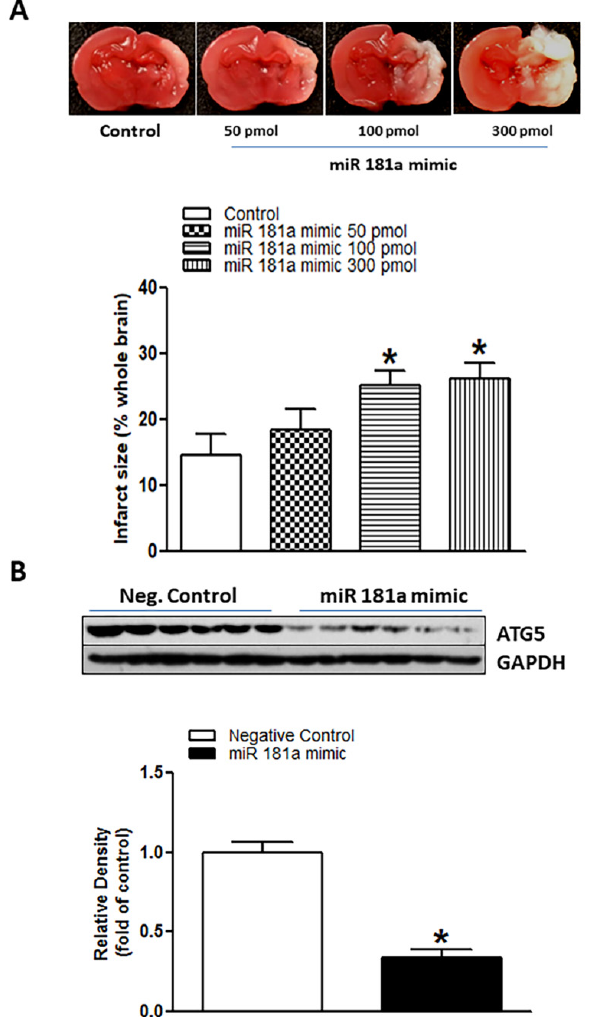
Figure 2. MiR-181a mimic reduced ATG5 protein level and exaggerated hypoxia/ischemia (H/I)- induced brain injury in neonatal pups. Different concentrations of miR-181a mimic and negative control were administered intracerebroventricularly (i.c.v.) on postnatal day 7 (P7) pups. Then, H/I procedure was conducted on postnatal day 9 (P9). After 48 h of H/I procedure, brain infarct size was determined by 2,3,5-triphenyltetrazolium chloride (TTC) solution staining ( A ). As shown in ( A ), miR-181a mimic administration significantly increased H/I-induced brain infarct size in a dose-dependent manner and reduced protein levels of ATG5 ( B ) in neonatal rat brains. Data are means ± SEM. * p < 0.05, control vs. miR-181a mimic, n = 7–12 animals/group. ATG5 protein level was evaluated by Western blotting in the P9 neonatal brain ( B ). Data are means ± SEM. * p < 0.05, control vs. miR-181a mimic (100 pmol), n = 6